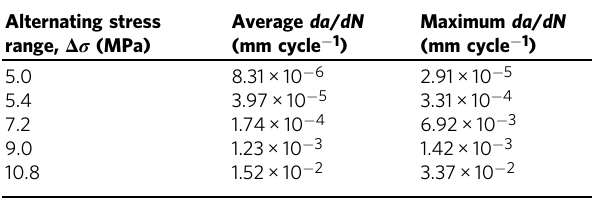
Table 1 Fatigue crack growth rates in copy paper. Alternating stress range, Δ σ (MPa)